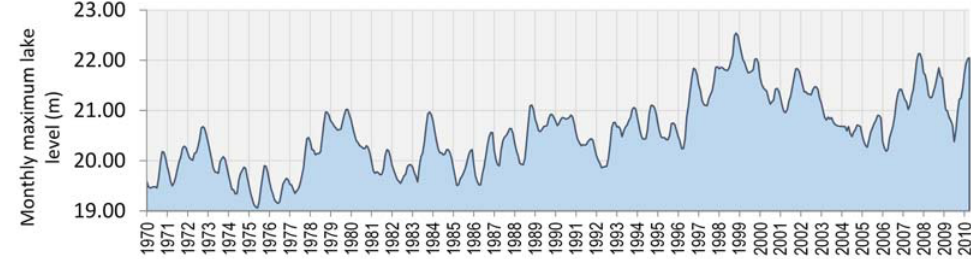
Figure 3. Hydrograph of monthly maximum lake level.